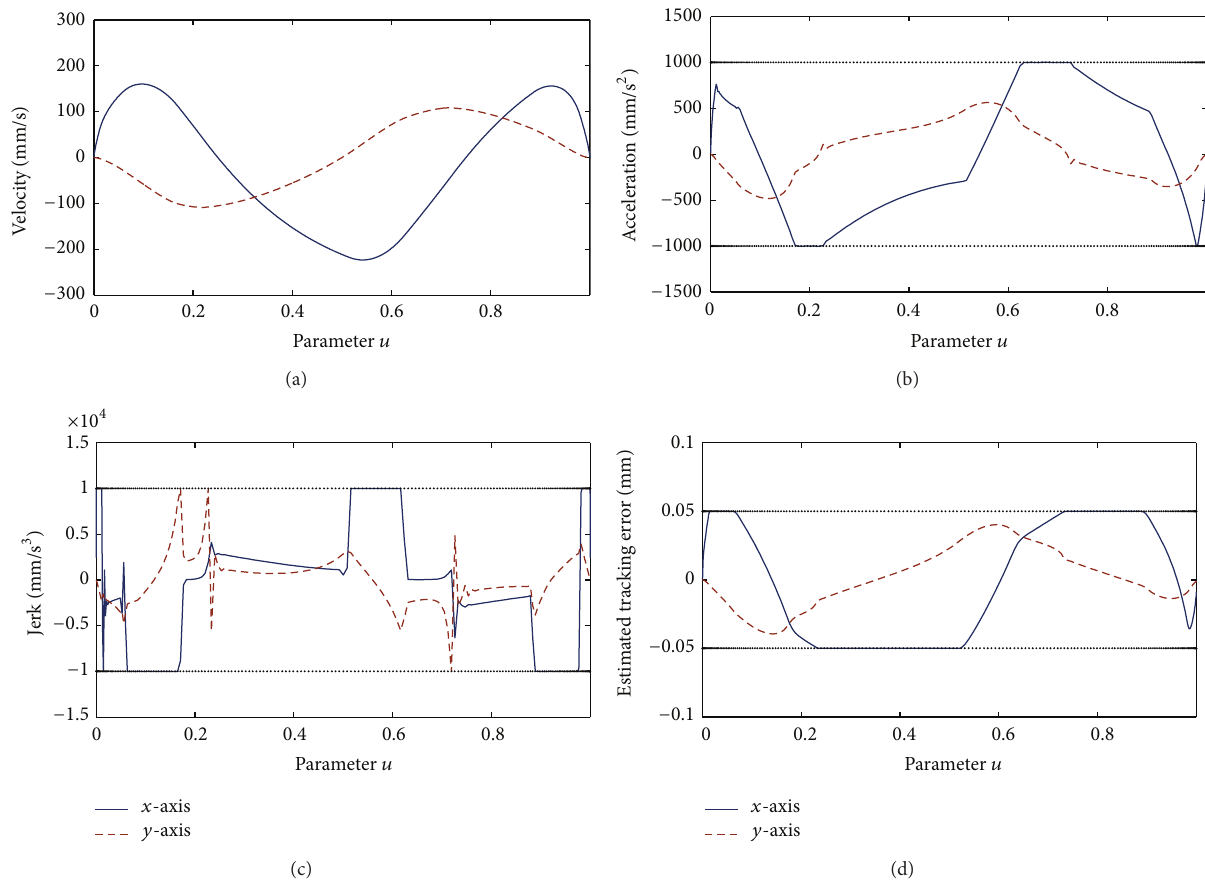
Figure 3: Bang-bang constraint structure of the minimum time trajectory for the ellispe